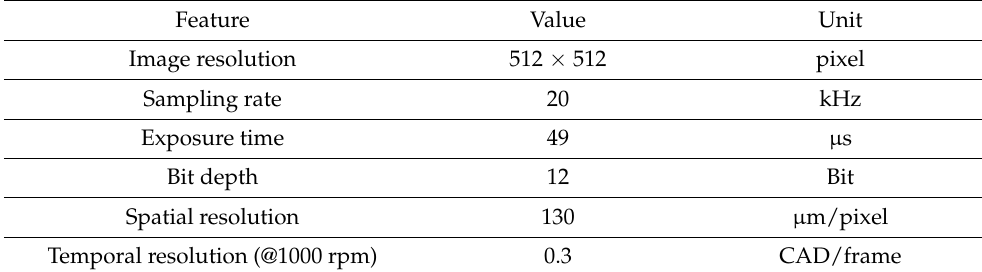
Table 2. High-speed camera technical features.